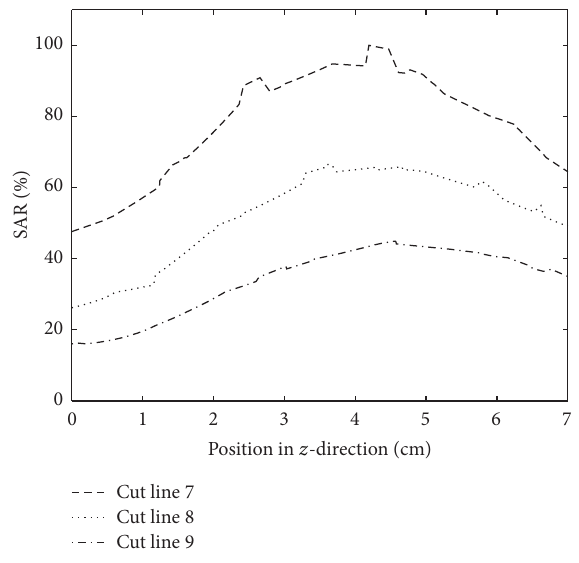
Figure 10: SAR distribution along three line segments (cut lines) which lie in the plane perpendicular to the water bolus/treated area interface.Theplaneisparallelandpassesthroughthethirdinductive post. The cut lines are parallel to the interface. Cut lines 7, 8, and 9 are located at the interface, at a depth of 1, 2, and 3 cm, respectively. SAR values are given as percentages of the highest SAR value along cut line